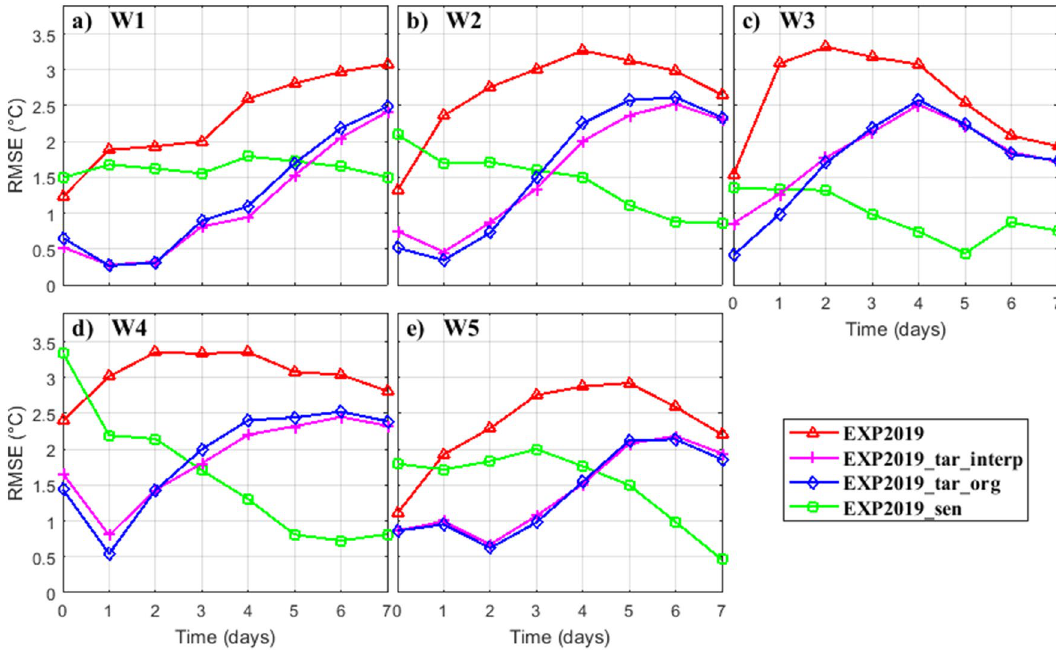
Figure 9. Temporal evolution of the vertically-averaged temperature profile RMSEs at five buoys between the four Observing System Experiments and the observations. Figures are plotted using MATLAB R2017a (http:// www. mathw orks.